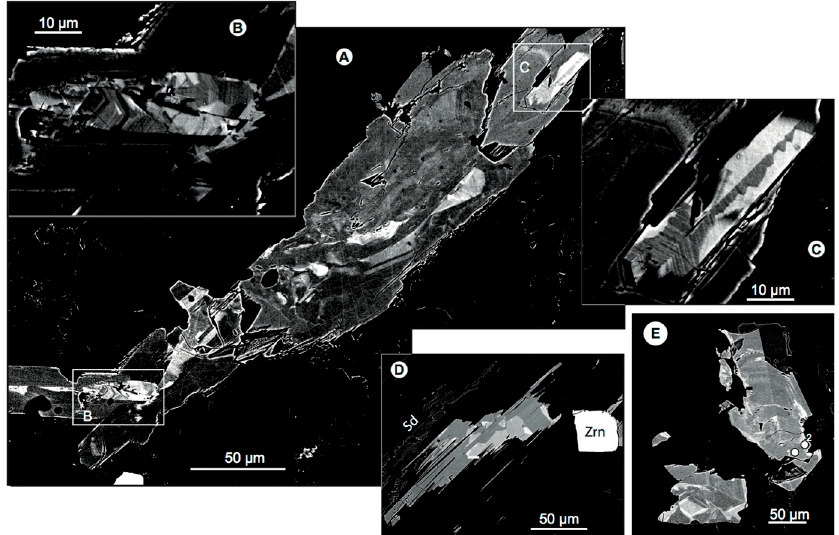
Figure 13. Sector zoning in the rutile form from the G1 suite, SEM-BSE images. Note the combination of oscillatory and sector zoning and that prismatic forms are characterized by low endowments in rare metals. ( A – C ) Large crystal from sample PAN-16-5b, showing small prisms incorporated in a larger prismatic crystal. ( A ) Overview. ( B , C ) details of the smaller prisms. ( D ) Another crystal from the same sample. ( E ) Rutile crystals from the G1a unit (sample PAN16-4). Note the similarity with the G1 rutile.